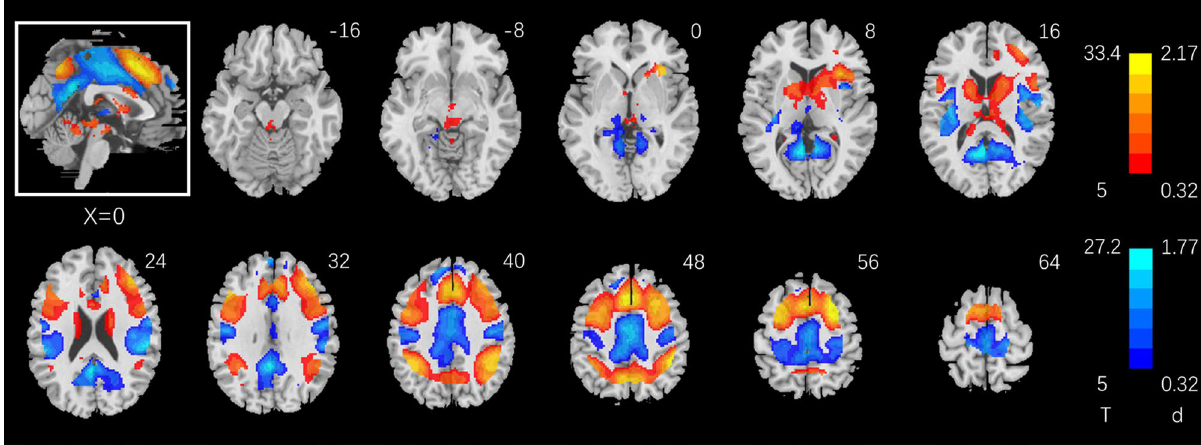
Figure 2. One-sample T-test of the contrast 2- minus 0-back. Voxel p < 0.05, FWE corrected. Voxels showing higher activity during 2- vs. 0-back and 0- vs. 2-back are shown in warm and cool colors, respectively. BOLD contrasts are overlaid on a structural image in axial sections from z = − 16 to + 64 with 8 mm gaps. Color bars show voxel T values and the corresponding Cohen’s d scores. Neurological orientation: right = right. The inset shows a mid-sagittal section of the clusters. Figures 2, 3, 4, 5A and 7A were generated by DPABI_V4.0_190305 (http:// rfmri. org/ 0-back” to identify regional responses to working memory. In addition to the T maps, effect size maps were computed using tools available in CAT12 toolbox (http:// www. neuro. uni- jena. de/ cat/), by approximating Cohen’s 2 t d 26 from the t-statistics using the expression d as employed in 30 . To examine how regional brain activa- √ df = tions to working memory varied across subjects in relation to accuracy and RT, we conducted whole-brain multiple regressions each on the contrast (2- minus 0-back) against differences in critical success index (2- minus 0- back; CSI 2–0 ) and differences in RT (2- minus 0-back; RT 2–0 ) of correct trials only as the regressor, with age, sex and years of education as covariates. We performed another whole-brain multiple regression on the contrast (2- minus 0-back) against PMAT24_A_CR with the same covariates. We evaluated the results at voxel p < 0.05, corrected for family-wise error (FWE) of multiple comparisons, by the DPABI.